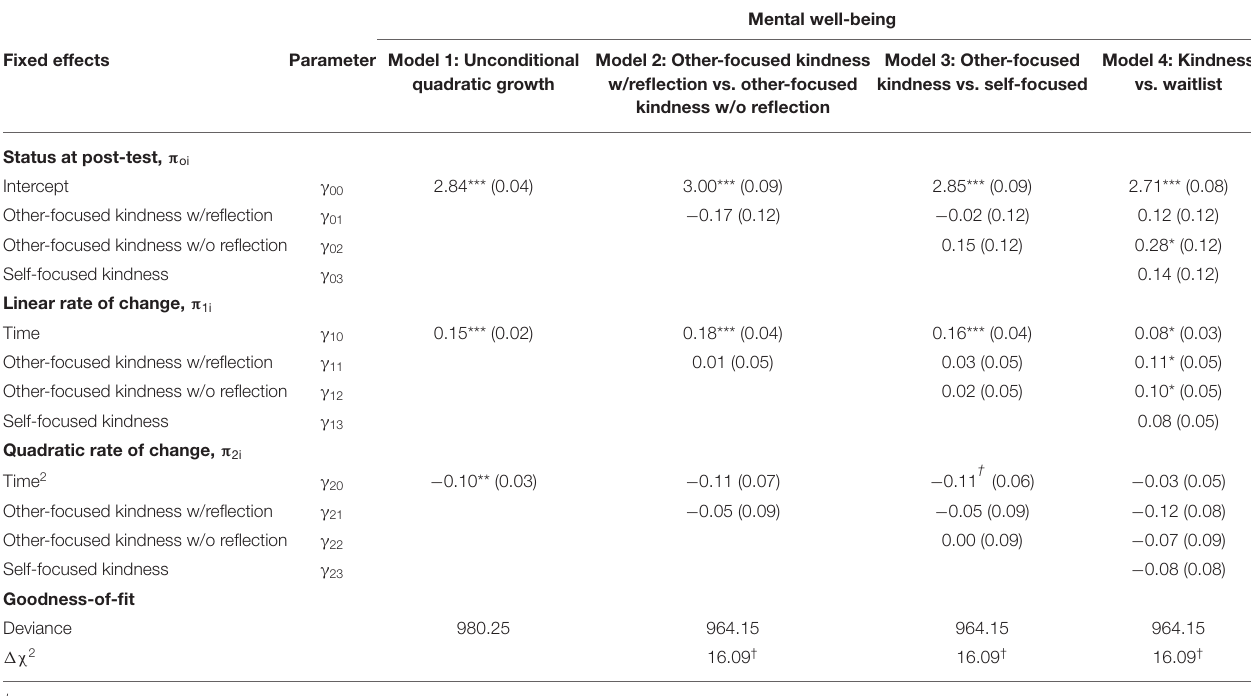
TABLE 3 | Parameter estimates and goodness of fit indices for multilevel growth curve models predicting changes in mental well-being up to 6-weeks follow-up comparing other-focused kindness and self-focused kindness with waitlist control.